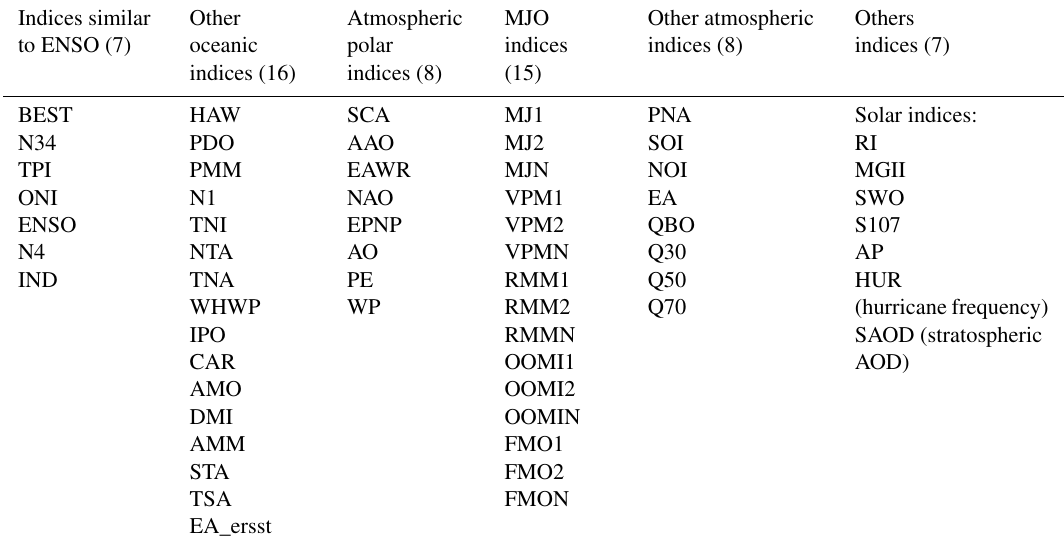
Table 2. Teleconnection indices and other time series used in this study. More details about these indices as well as their sources are given in Fig. A6 in the